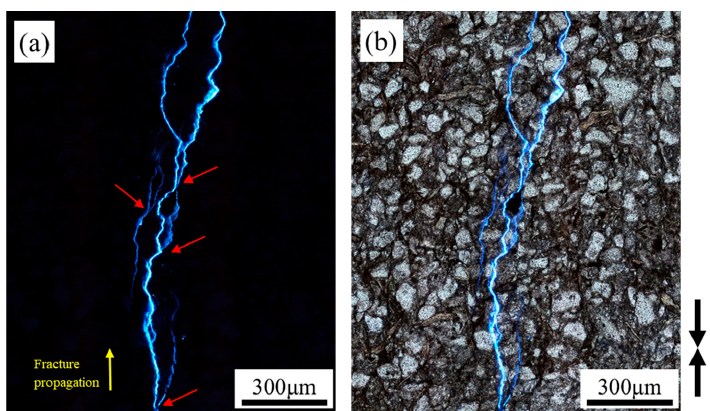
Figure 5. Branching of hydraulically induced fractures within an Inai shale specimen (Ki-2 in Table 2) ( a ) under UV light and ( b ) under a single nicol with UV light. The pair of black arrows next to ( b ) represents the loading direction. Branching occurs at an acute angle (red arrows) and the branches run almost parallel to the fracture propagation direction.